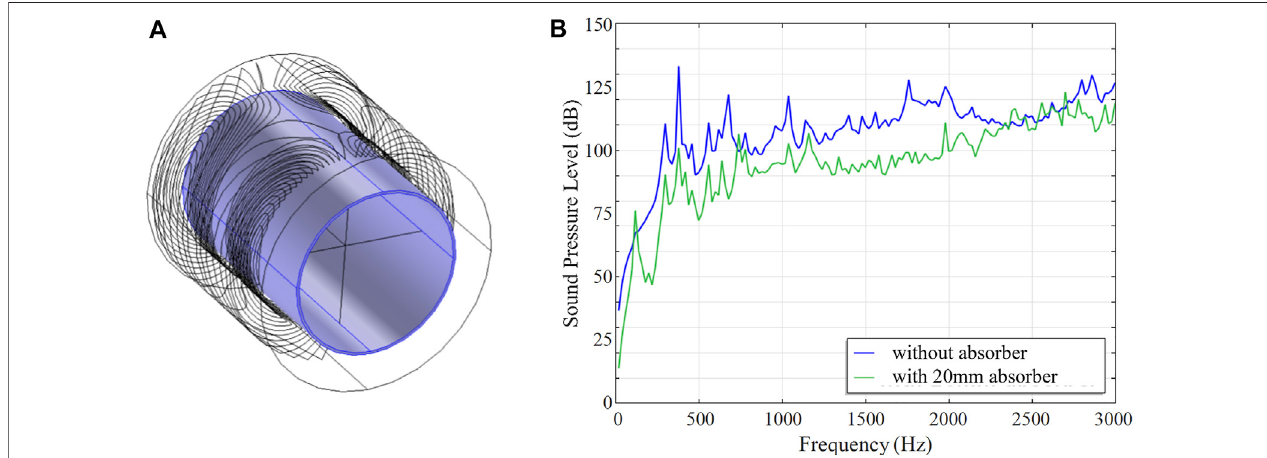
FIGURE7| Noisereductionwithanabsorbingceramic.3Dmodelsofthegradientcoilwith (A) asingleinnerlayerabsorberand (B) innerandouterlayerabsorbers. (C) Simulated SPL spectra at various absorbing layer thicknesses. (D) Simulated average SPL and acceleration at various absorbing layer thicknesses.